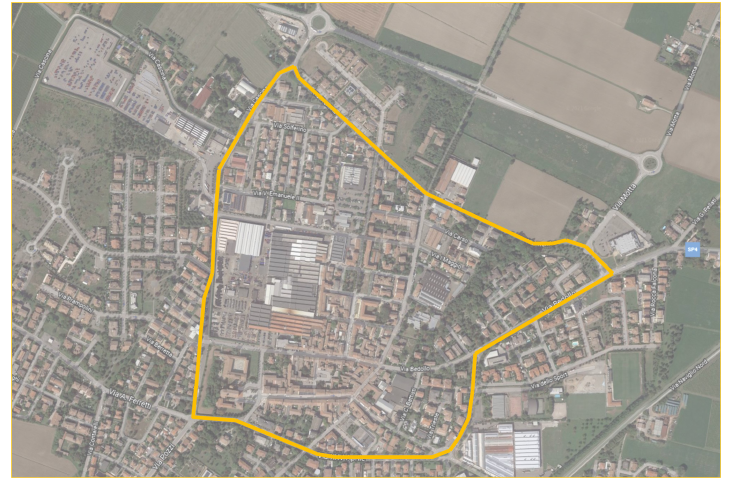
Figure 17. Path followed in the urban tests.